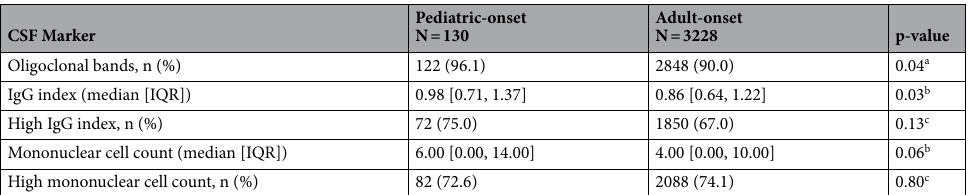
Table 2. Crude cerebrospinal fluid values compared between pediatric- and adult-onset cases within 1 year of MS onset. IQR interquartile range. a By Fisher’s exact test. b By Wilcoxon rank-sum test. c By chi-squared test.